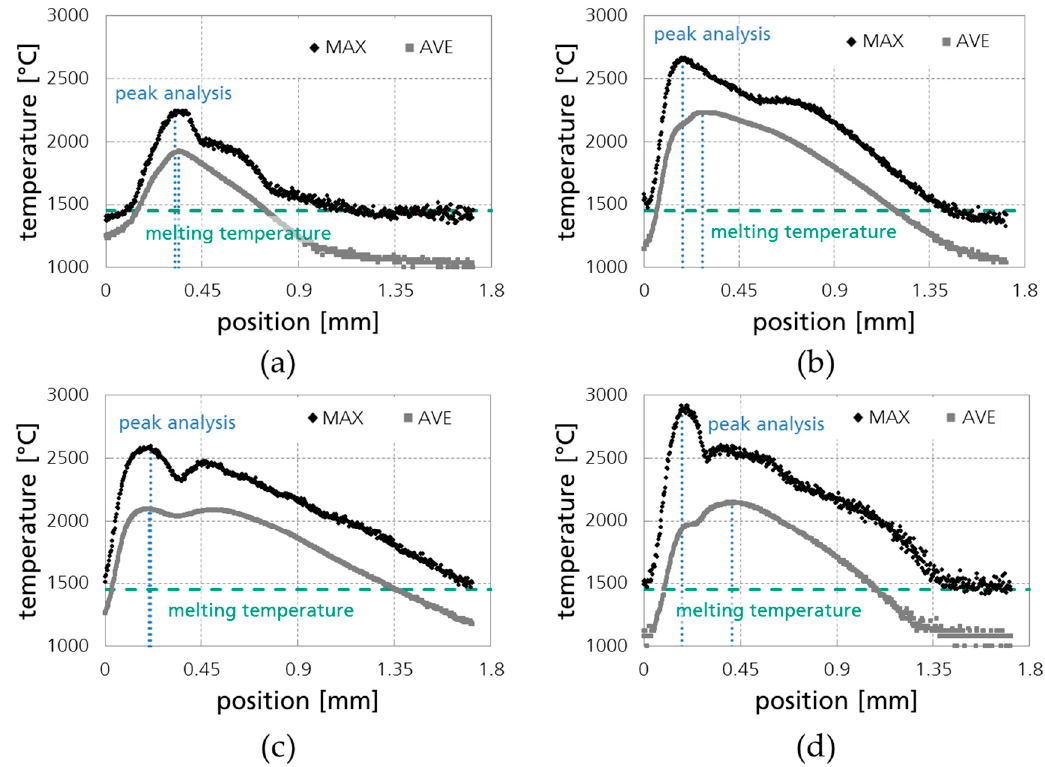
Figure 17. Spatially resolved temperature profiles along the symmetry axes of the cut front for average temperature T i and maximum temperature T max calculated with e = 1 from all single images within the complete measurement period of 500 ms of 12 mm stainless steel cut with the following parameters: ( a ) Set #1: Static beam shaping; and different values of the longitudinal, linear beam oscillation parameters: ( b ) Set #2: 300 µ m amplitude and 500 Hz frequency; ( c ) Set #3: 550 µ m amplitude and 500 Hz frequency; ( d ) Set #4: 300 µ m amplitude and 2000 Hz frequency.